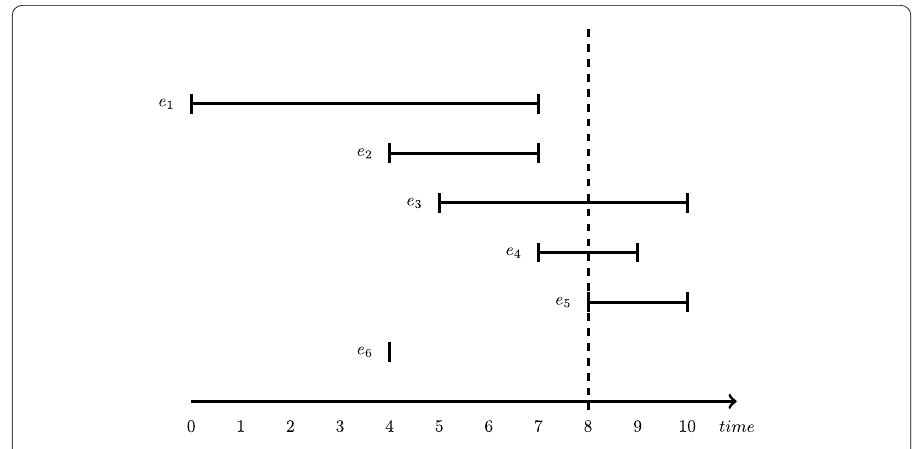
Figure 2 An example of an edge generation by the CDM. Dashed line corresponds to the C (8) =